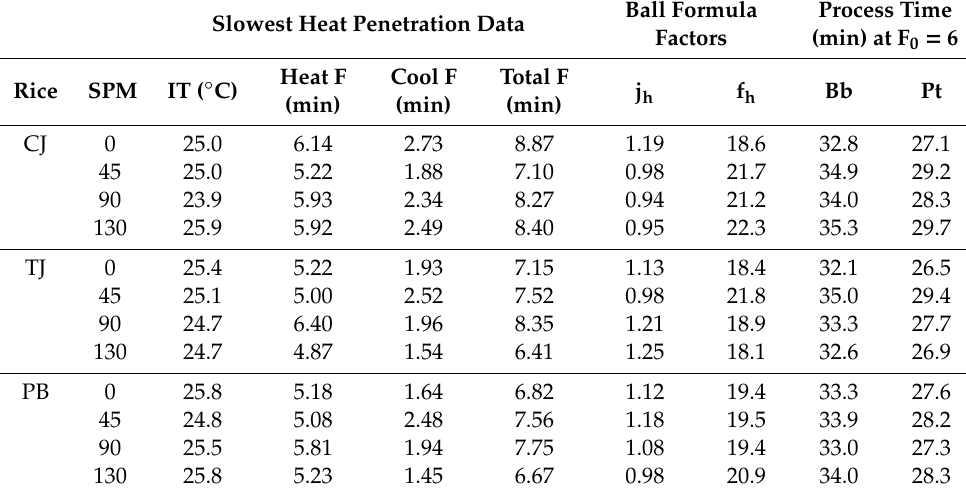
Table 1. Ball factors and cook times for three rice varieties at four process speeds using slowest heat penetration data 1,2